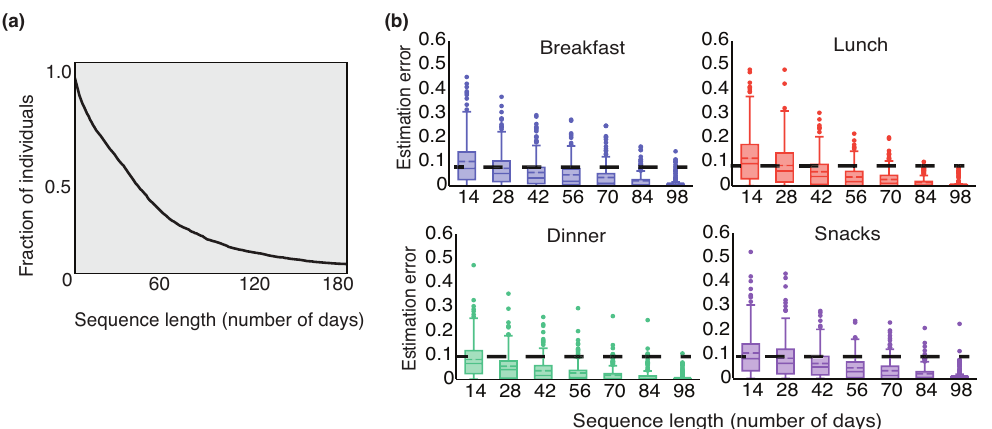
Figure 2. ( a ) Kaplan–Meier estimated survival analysis for the number of complete recorded days. ( b ) Decreasing trend in estimation error as the consumption sequence length (number of recorded days) increases. We chose 28 days for analysis as this allows less than 0.1 estimation error in recurrent